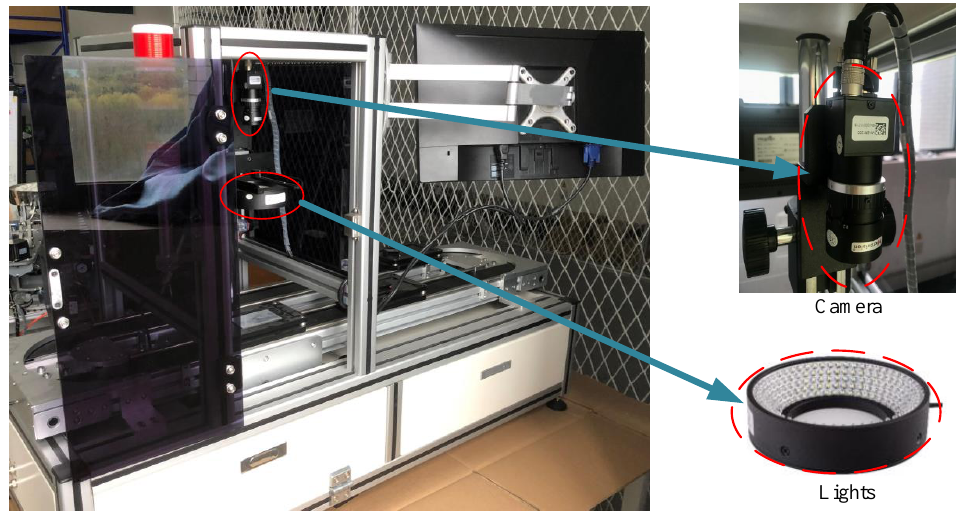
Figure 4. Image acquisition platform.